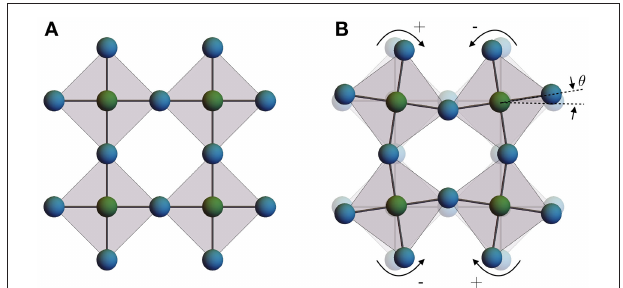
(B) the same layer with a non-zero tilt angle θ , showing the constrained motion of neighboring octahedra due to shared inter-octahedral X -sites.